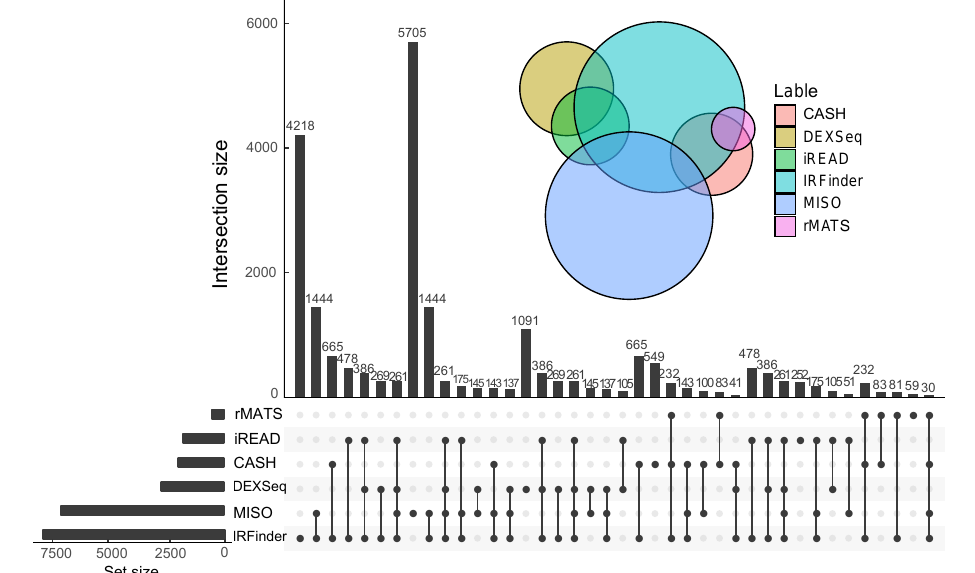
Fig. A1 A combination diagram of Venn and UpSet shows the IR intersection of six methods on